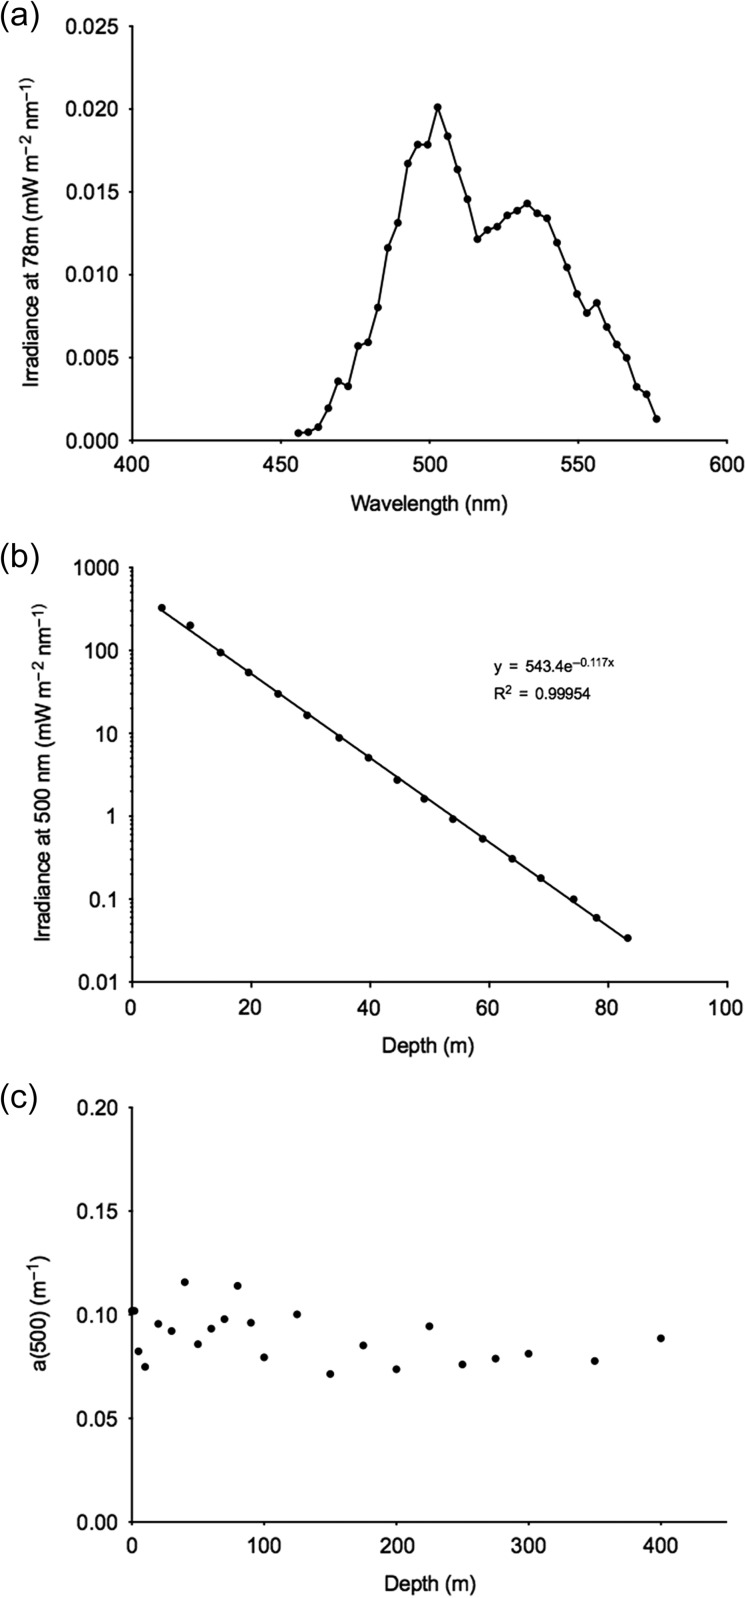
(a) Downwelling irradiance in Lurefjorden in February 2010 at 78 m depth as a function of wavelength. (b) Downwelling irradiance at 500 nm as a function of depth. The attenuation coefficient (K500 = 0.117 m−1) of downwelling irradiance was calculated by fitting y = 543.4e−0.117x, (R2 = 0.9995) where y is observed irradiance at depth (x). (c) Light absorption coefficient calculated according to a = 2.303A/0.1 where A is the measured absorbance at 500 nm. We assumed the ratio between K and a was the same above and below 80 m and obtained an estimate of the attenuation between 80 and 400 m depth (K400 = 0.102, Table II).